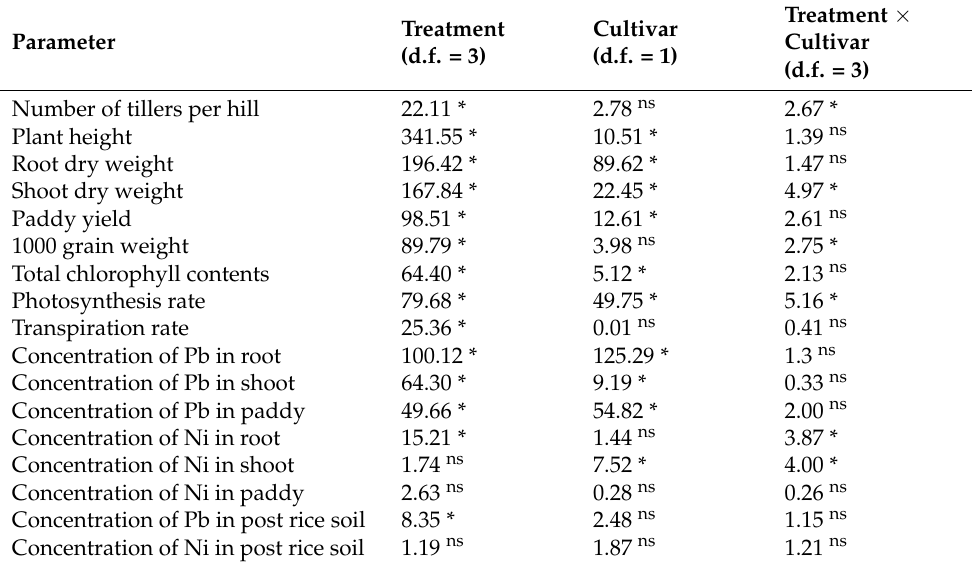
Table 4. F-values of two ways ANOVA for the effect of varying application rates of phosphatic fertilizer on growth, yield, physiological, and biogeochemical responses of coarse and fine rice ( Oryza sativa L.) cultivars receiving city effluent